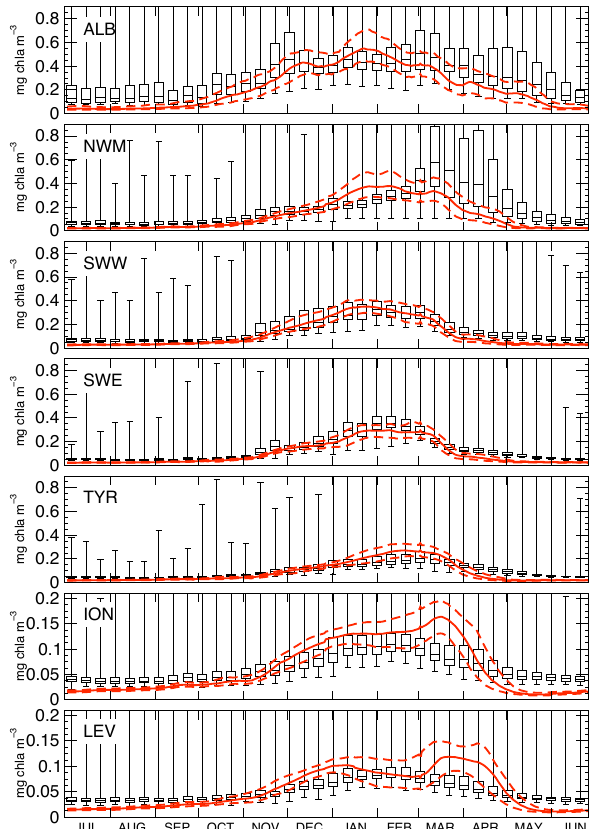
Fig. 6. Surface chlorophyll seasonal cycle (mgchl- a m − 3 ) for the period 1999–2004 simulated by OPATM-BFM model (solid red lines=median, dashed red lines=25 and 75 percentile) compared with data from SeaWIFs (box-plot). Data are spatially aggregated (spatial median) in regions corresponding to those presented in Fig. 1.